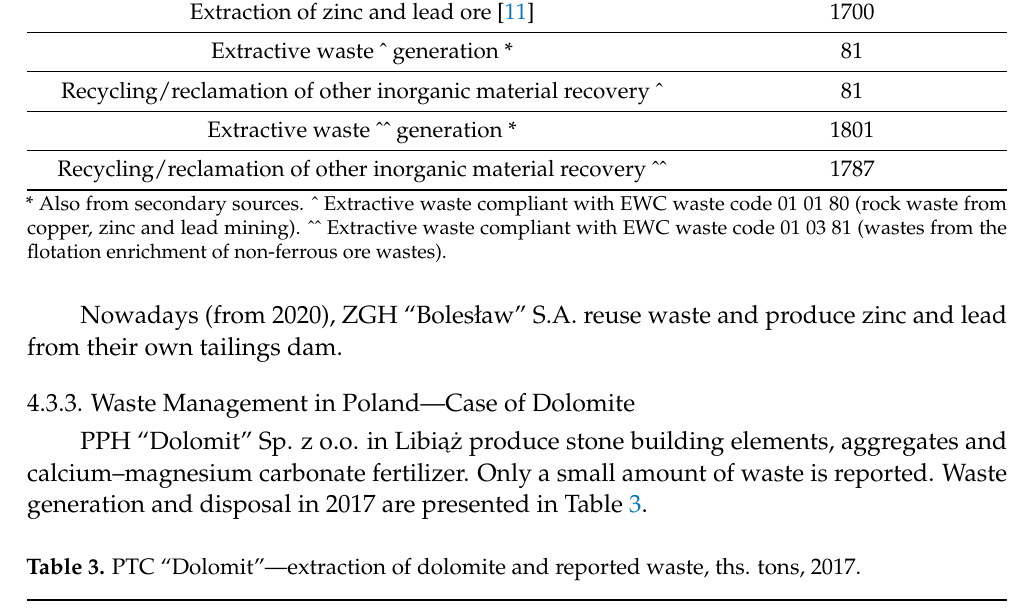
Table 3. PTC “Dolomit”—extraction of dolomite and reported waste, ths. tons, 2017. Extraction of dolomite (Libi ˛a˙z deposit) [11] 580 Extractive waste ˆ generation 5 Deposit into or onto land, e.g., landfill ˆ 0.7 Extractive waste ˆˆ generation 0.1 Deposit into or onto land, e.g., landfill ˆˆ